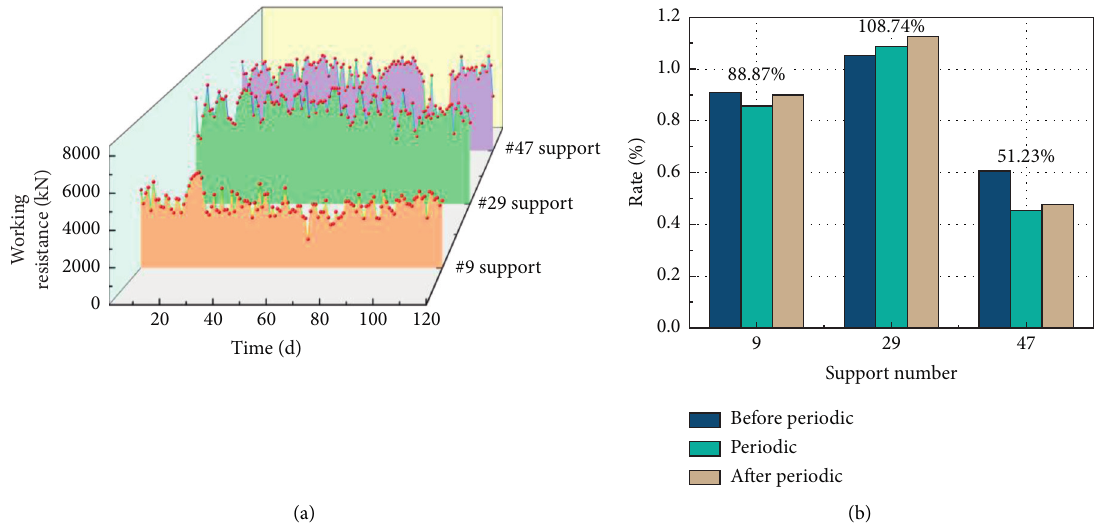
Figure 1: Support resistance and load ratio of back to front legs in different areas. (a) Support resistance. (b) Load ratio of back to front